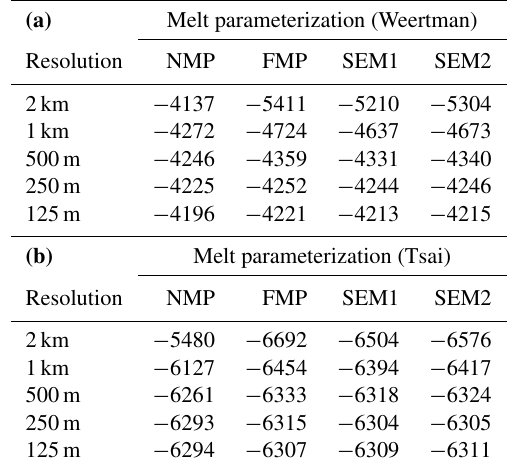
Table 3. Change in volume above floatation ( (cid:49) VAF inGt) in ex- periment 2 for the Weertman (a) and Tsai (b) friction